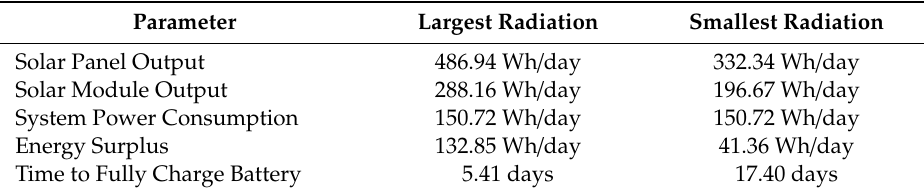
Table 7. The parameters for the solar